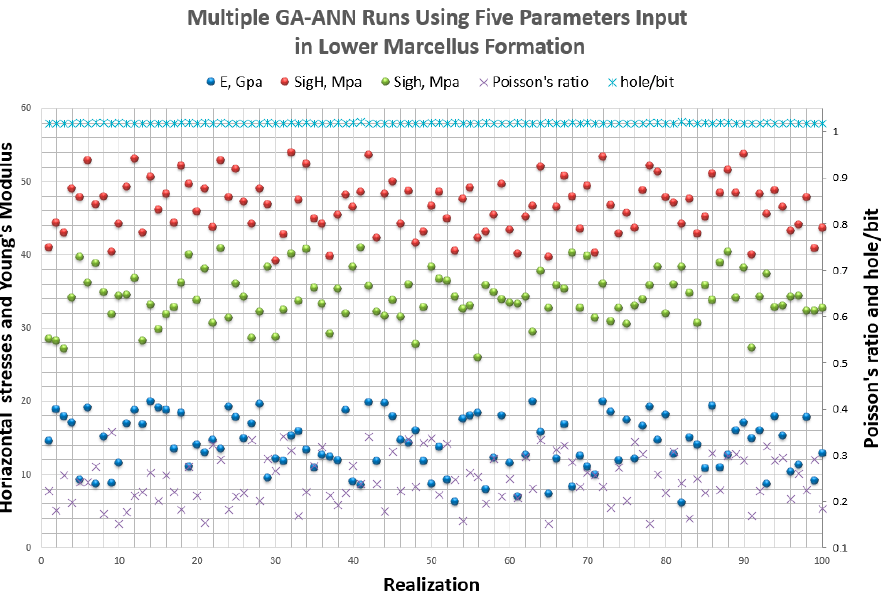
Figure 3. Results of hole/bit size ratio, Poisson’s ratio, Young’s modulus, and horizontal stresses of 100 ANN-GA realizations.